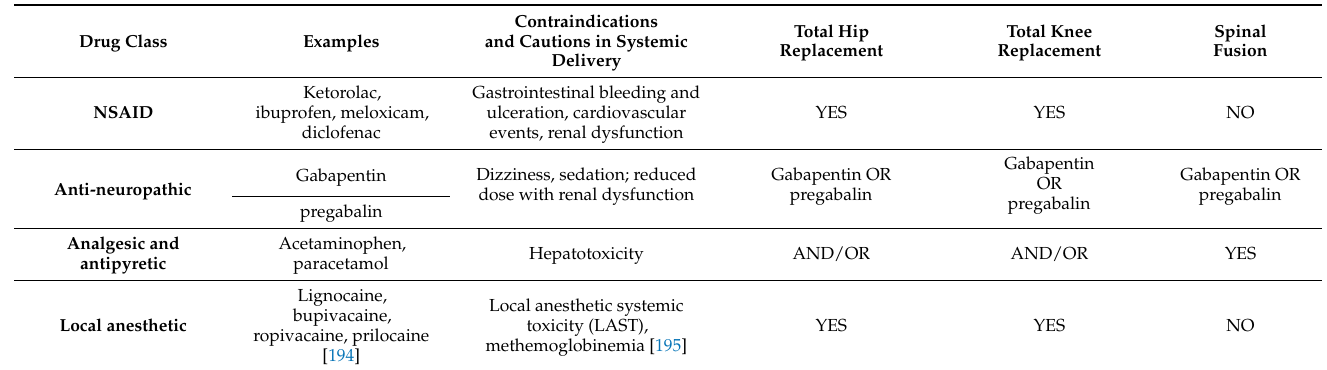
Table 6. Examples of the drugs used in multimodal pain management in commonly performed orthopedic surgeries